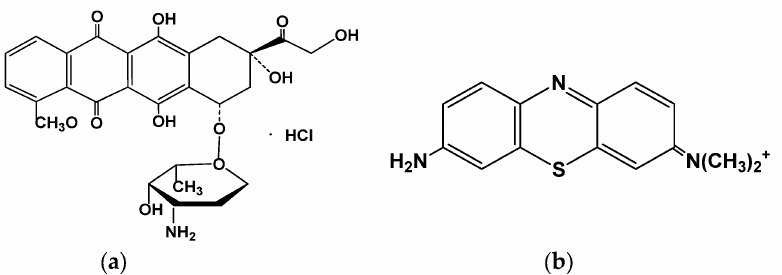
Figure 1. Chemical structure of doxorubicin ( a ) and Azure A ( b